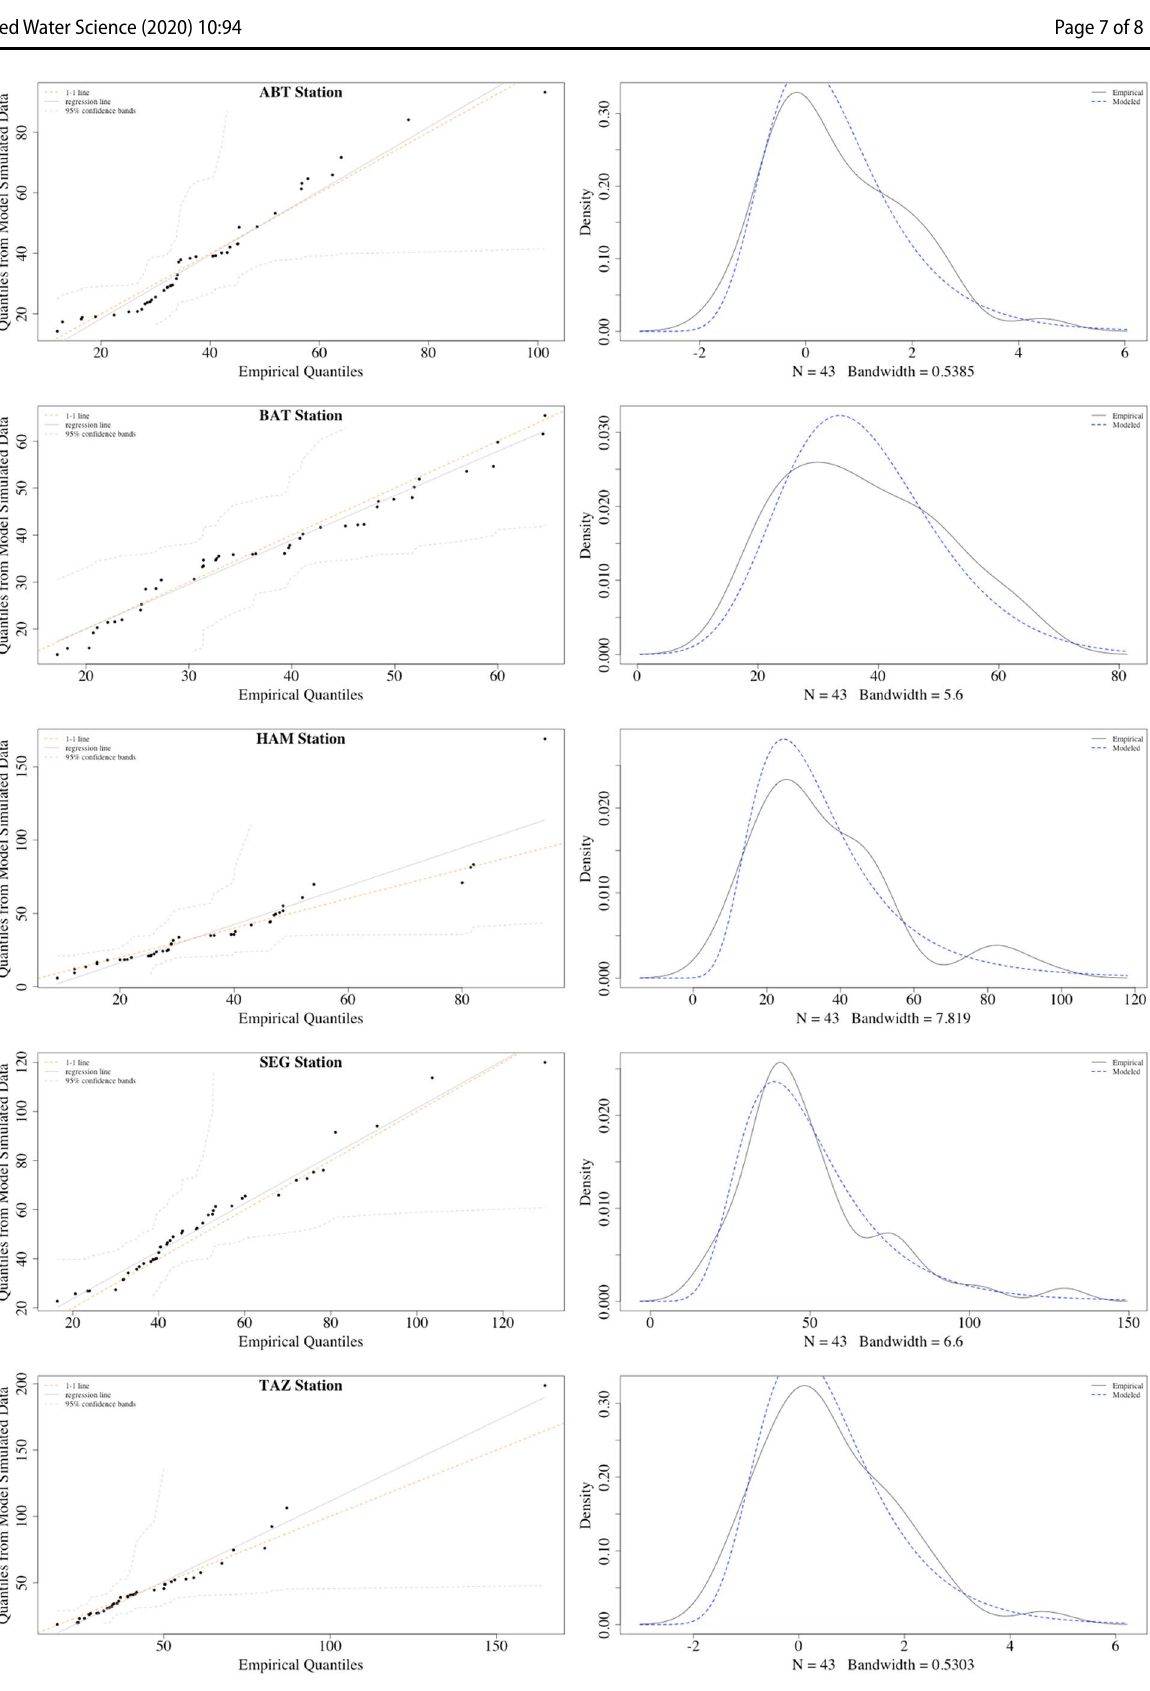
Fig. 6 Quantile and density plots for each